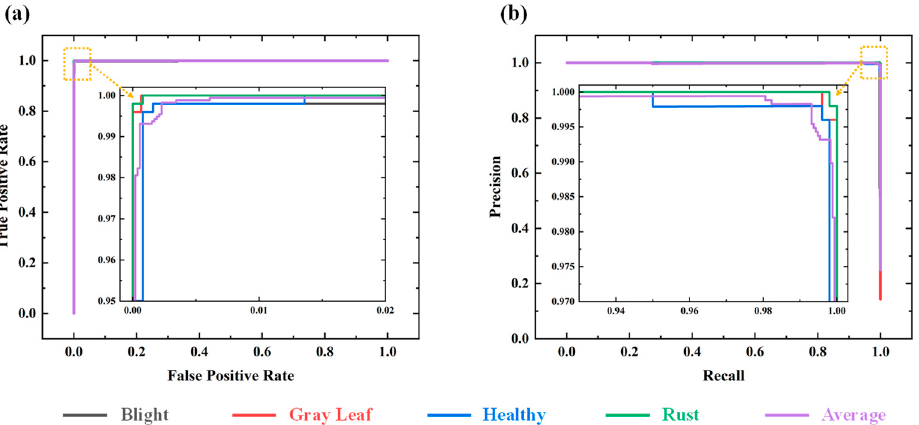
Figure 4. Results of the quantitative analysis. ( a ) ROC curve of maize disease prediction. ( b ) PR curve of maize disease prediction. Note that the yellow rectangle and arrow are for expanded dis- play.